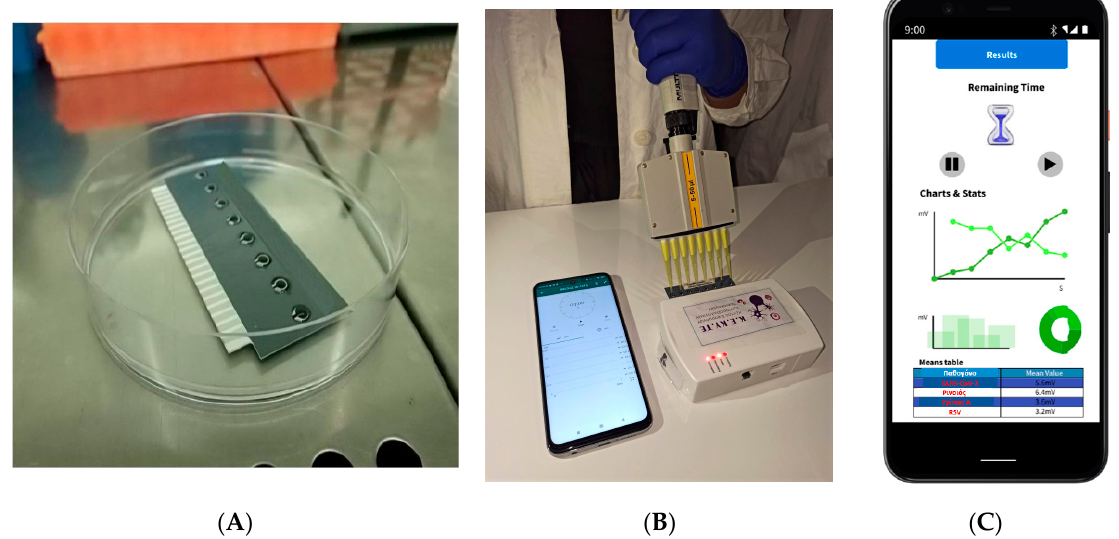
Figure 1. Biosensor’s set-up. Carbon screen-printed multi-electrode (8 × ) cassettes were prepared with 3D membrane-engineered cell cultures ( A ). The electrode strip was attached to a portable custom-made potentiometer connected to a smartphone device via Bluetooth for measurements’ recording immediately after the sample addition ( B ). The bio-electric signal produced was presented as a voltage vs. time graph on the screen of a smartphone ( C ).